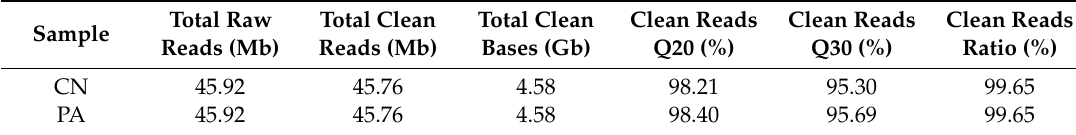
Table 1. Summary of sequencing reads after filtering.